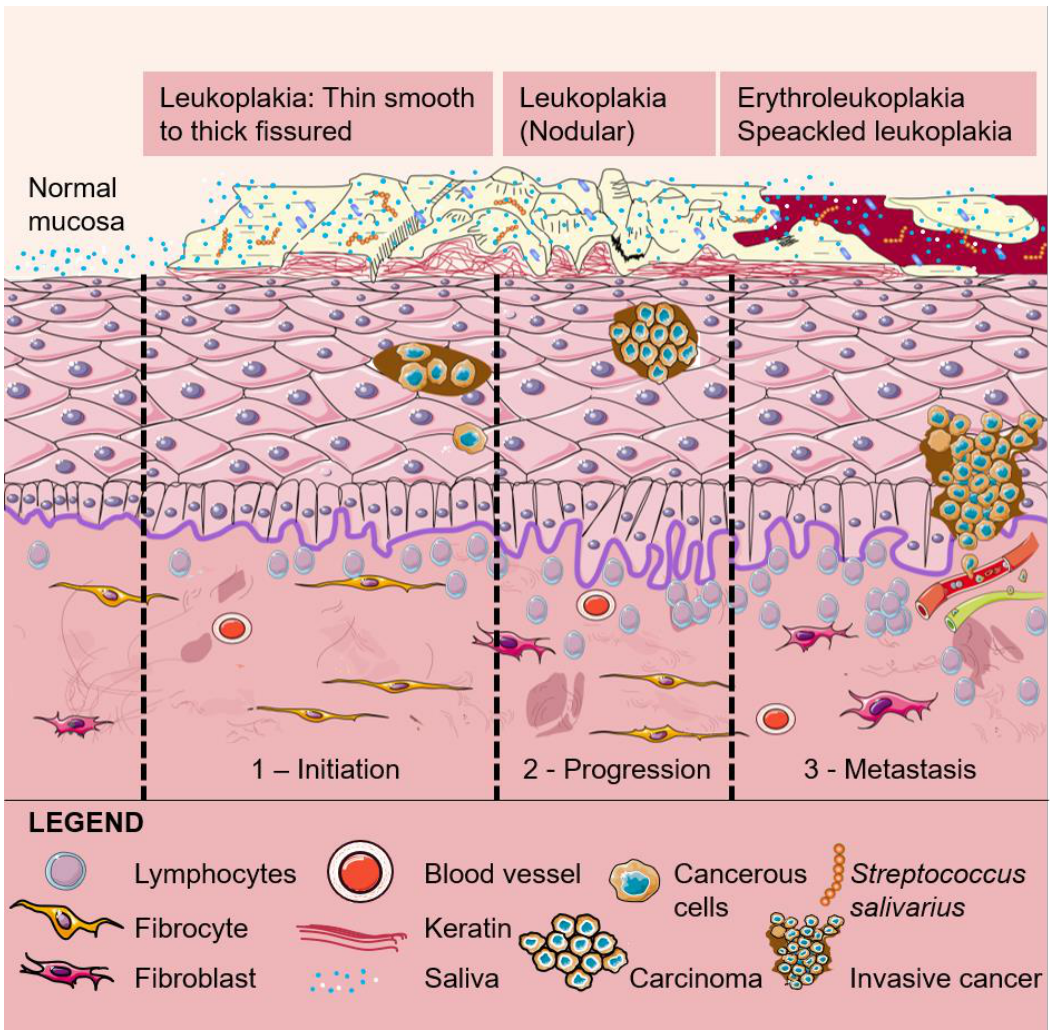
Figure 3. The various clinical appearances of leukoplakia with expected underlying microscopic changes are shown. Leukoplakia is a pre-malignant, pre-cancerous or potentially malignant lesion or condition, which means that there is an increased risk of future malignant transformation into a squamous cell carcinoma either at the site of the leukoplakia or elsewhere in the oral cavity. Lesions become progressively more “severe” toward the right, culminating in erythroleukoplakia, which most frequently demonstrates severe epithelial dysplasia and carcinoma in situ when studied histologically. It should be emphasized that the scheme does not necessarily represent a chronological change, but rather it shows the potential presentations of leukoplakia. Homogeneous leukoplakia is a uniform, flat, thin and white plaque, with or without fissuring and with a gradual increase of hyperkeratosis and acanthosis. Leukoplakia can also be non-homogeneous, being nodular or flat with a mixed white and red discoloration (“erythroleukoplakia”). The histopathologic features of leukoplakia may vary from hyperkeratosis with or without epithelial dysplasia to various degrees of epithelial dysplasia, carcinoma in situ and even invasive squamous cell carcinoma.